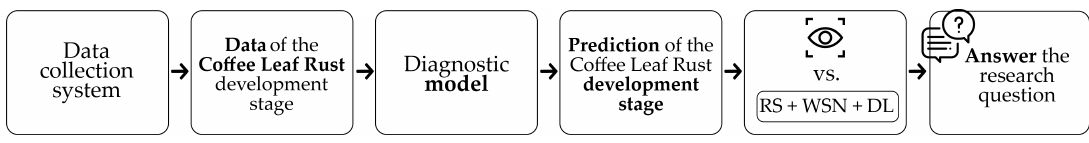
Figure 5. Proposed methodology flowchart (based on